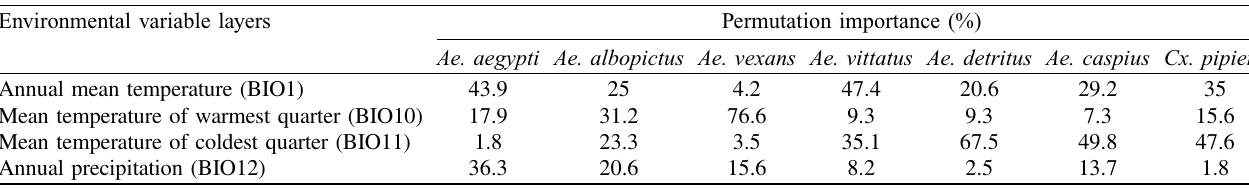
Table 5. Main contribution of the environmental variables used for modeling.